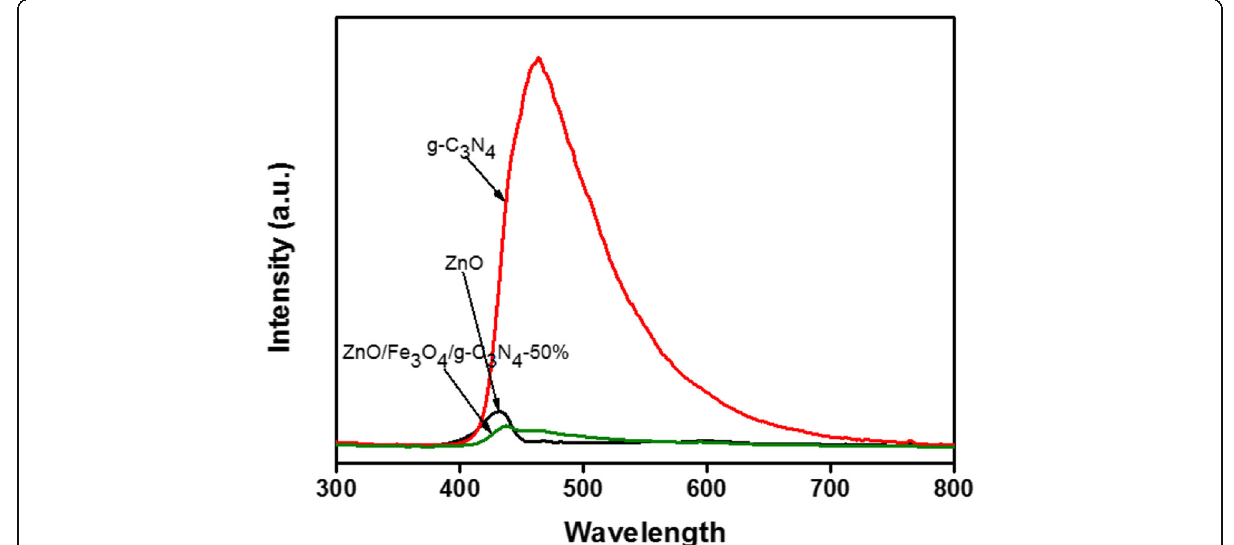
Fig. 6 PL spectra of ZnO, g-C 3 N 4 , and ZnO/Fe 3 O 4 /g-C 3 N 4